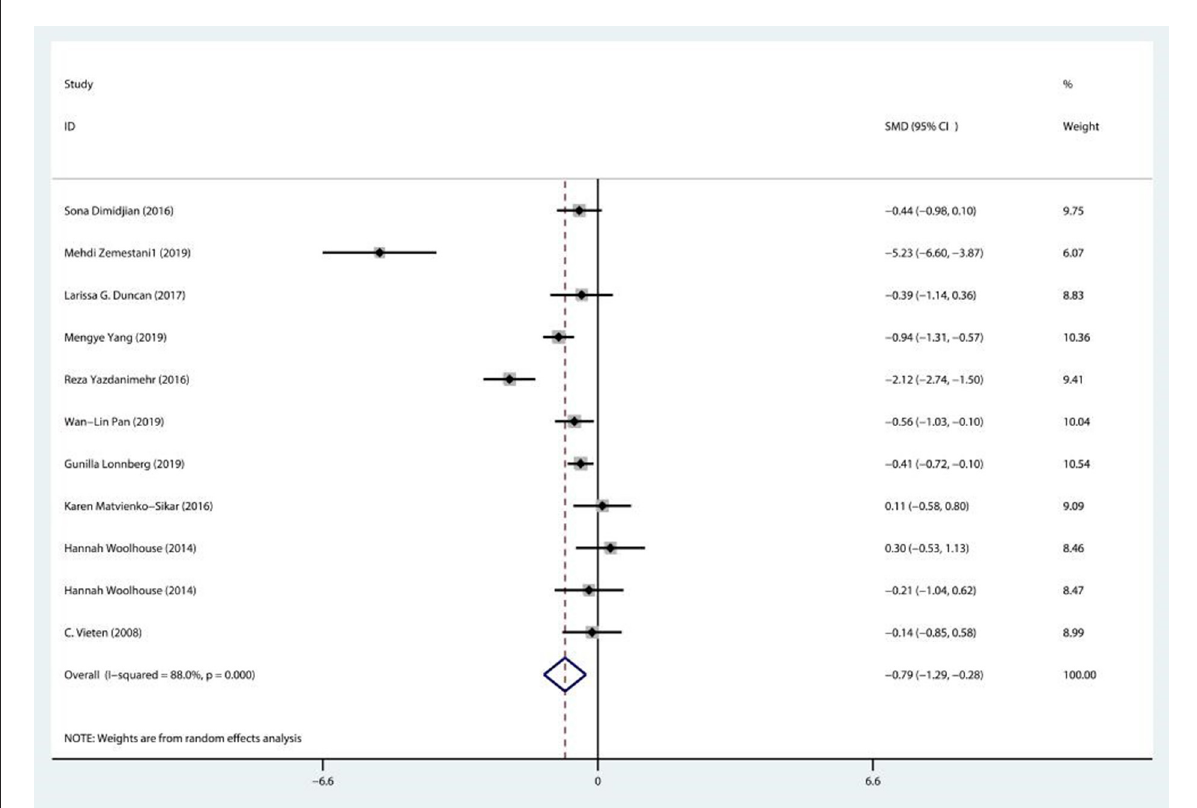
FIGURE4 Heterogeneity test of the effect of mindfulness meditation on depression during